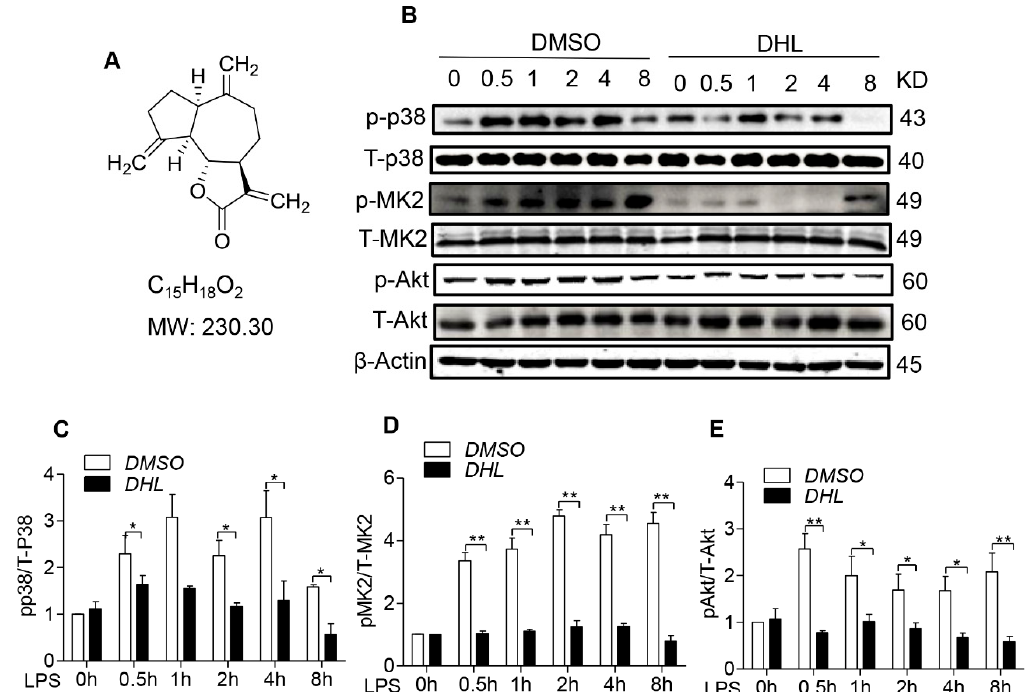
Figure 1. DHL reduced p38 MAPK, MK2 and Akt phosphorylation in LPS-stimulated RAW264.7 cells. ( A ) Chemical structure of DHL. RAW264.7 cells were pretreated with either 5 µ mol / L DHL or 0.1% DMSO for 0.5 h before stimulation with LPS (100 ng / mL) for 0, 0.5, 1, 2, 4 and 8 h. ( B ) The protein expression levels of p-p38 MAPK, p38 MAPK, p-MK2, MK2, p-Akt and Akt were evaluated by western blotting. ( C – E ) Quantitative analysis of the ratios of p-p38 / T-p38, p-MK2 / MK2 and p-Akt / Akt normalized with β -actin was performed using Image J software. Data represents means ± SEM based on three independent experiments, * p < 0.05 and ** p < 0.01.